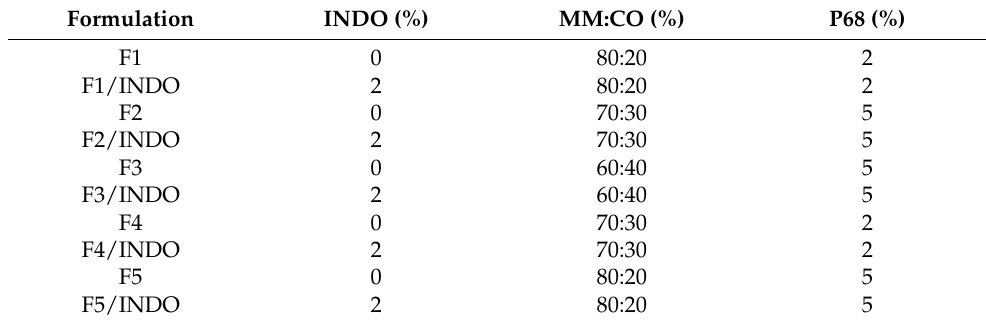
Table 1. Composition of NLC